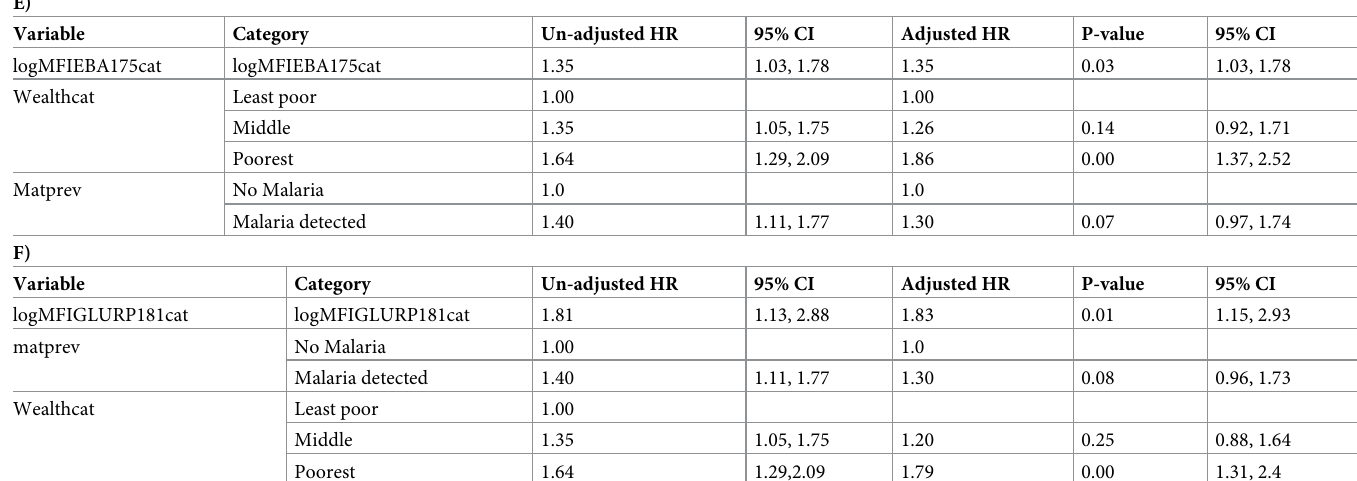
Matprev = categorization of gestational malaria